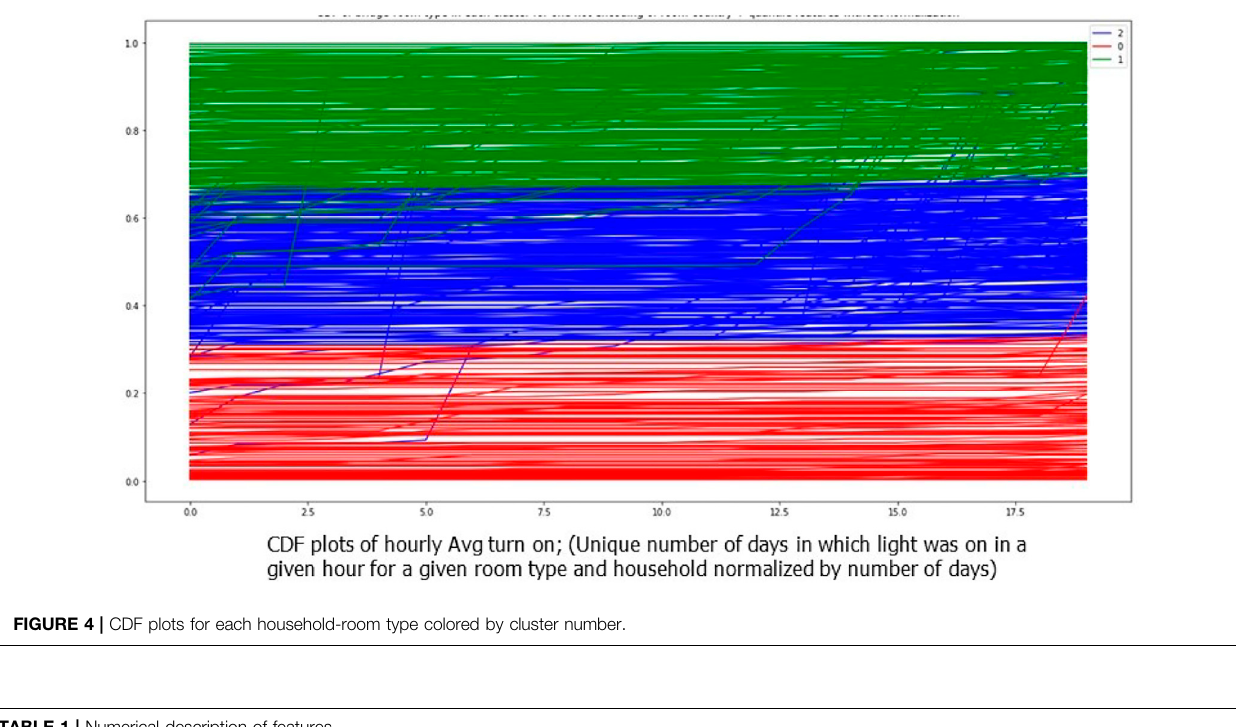
TABLE 1 | Numerical description of